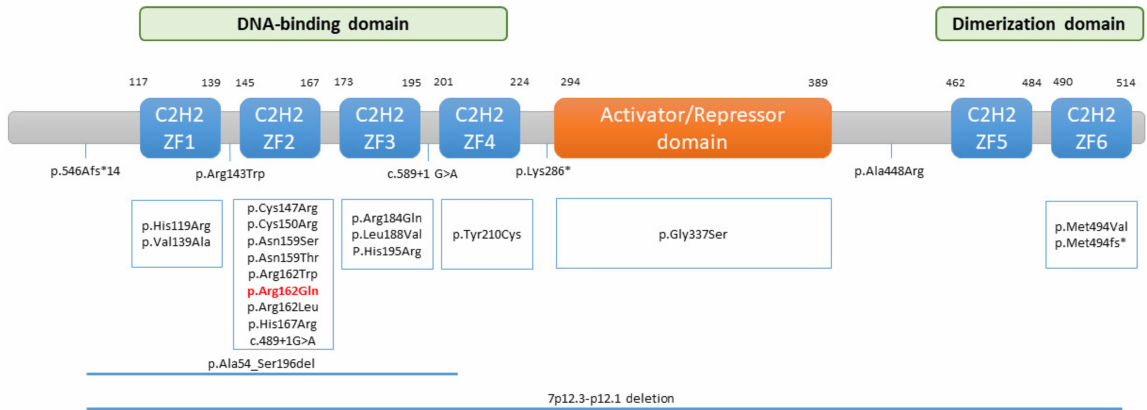
Figure 3. Schematic representation of the structure of human IKAROS protein encoded by the IKZF1 gene. The DNA-binding domain consists of four zinc-finger motifs (ZF1–ZF4) and the dimerization domain of two (ZF5–ZF6). The p.Arg162Gln variant found in our patient is highlighted in red and affects the ZF2 domain. Other amino acid positions of IKAROS variants identified in CVID patients are indicated. ZF: